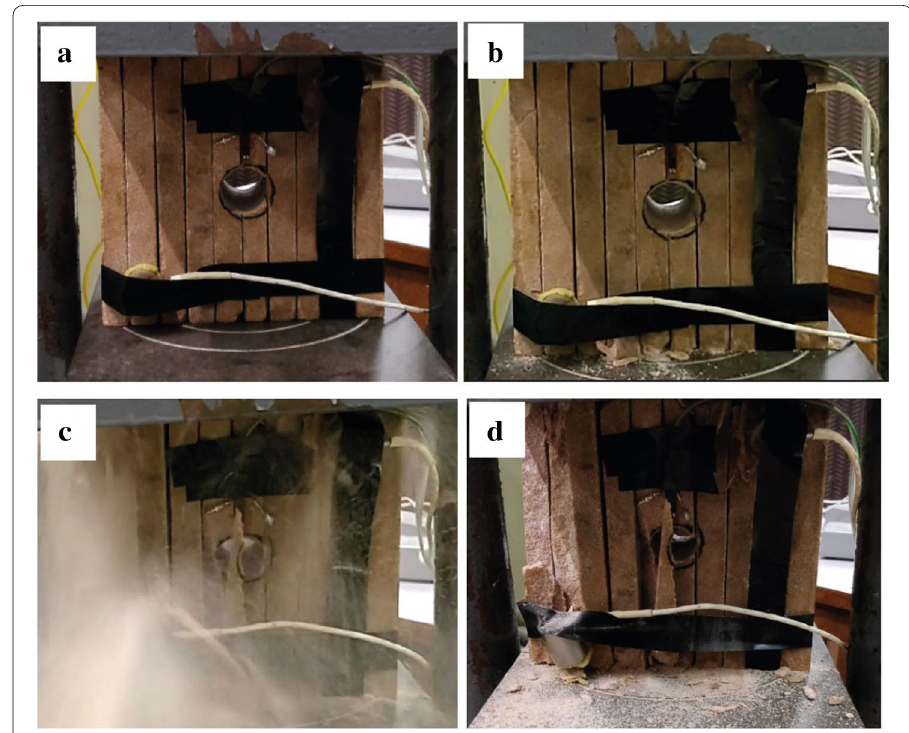
Fig. 10 Failure in sandstone block with vertical joints, as the load is applied following failure pattern results starting from ( a – d ). a pretest setup (no load is applied), b loading started, small crack is generated near the tunnel, c, d failure at ultimate